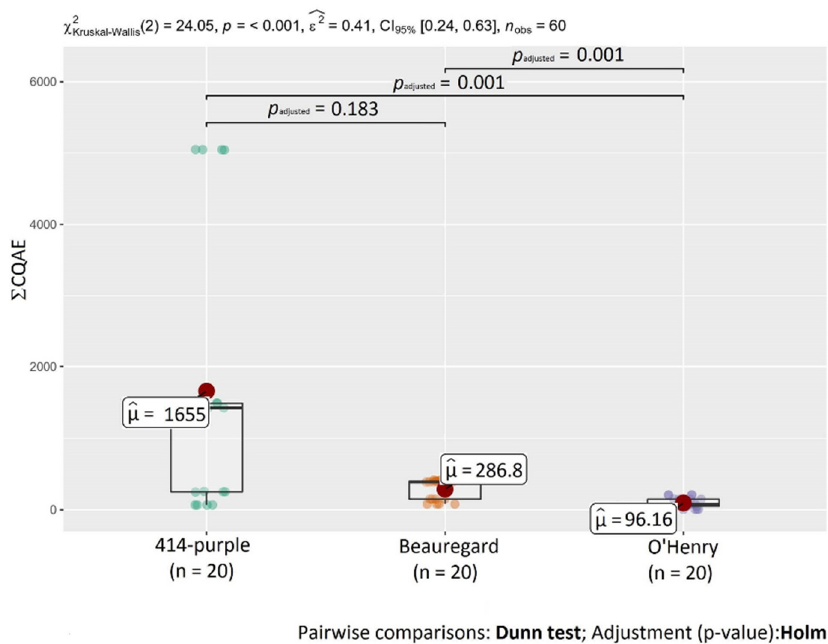
Figure 3. Statistical differences in the content of chlorogenic acid equivalents ( Σ CQAE) between monitored SP varieties . Table 1. Individual chlorogenic acids, total polyphenol content, and antioxidant activity in raw and heat-treated sweet potatoes.